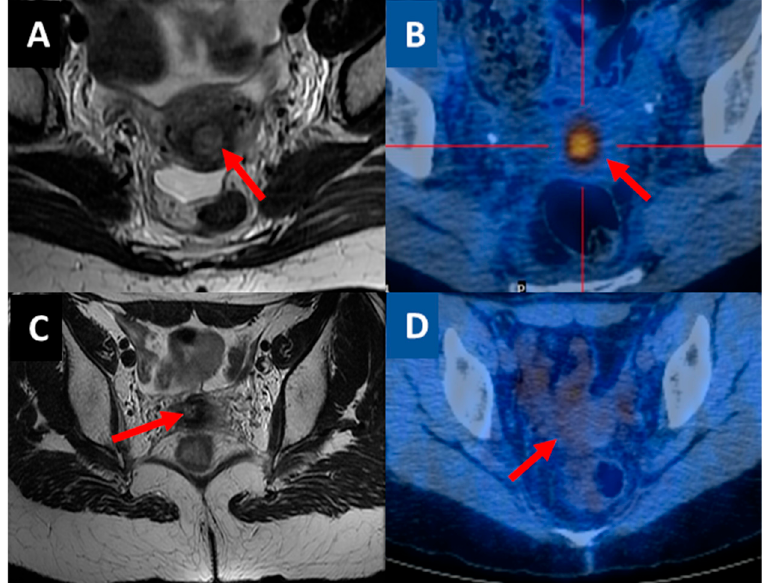
Figure 2. ( A ) and ( B) show agreement between MRI and 18 F-FDG PET/CT after CCRT. The red arrows indicate the residual tumor (partial response). ( C ) and ( D ) show disagreement between MRI and 18 F-FDG PET/CT after CCRT. In panel ( C ) the red arrow indicates the residual tumor (partial response) and in ( D ) the red arrow indicates the absence of a tumor (complete response) in MRI and 18 F-FDG PET/CT, respectively.